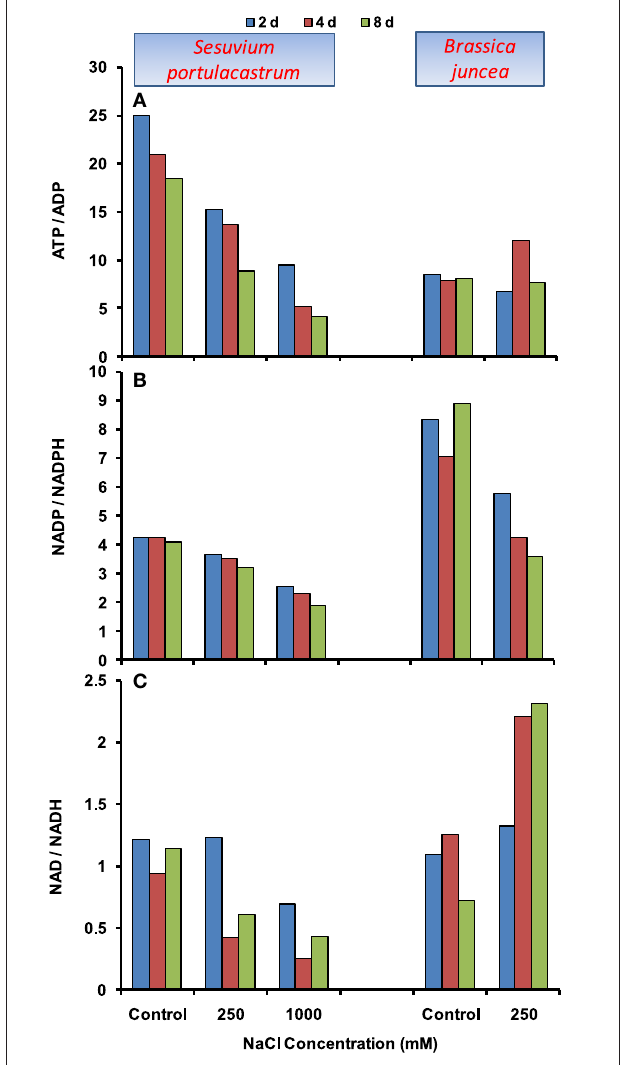
FIGURE 5 | Time dependent modulation of ATP/ADP (A), NADP/NADPH (B), NAD/NADH (C) ratios in NaCl exposed Sesuvium portulacastrum and Brassica juncea . All values represent mean of three